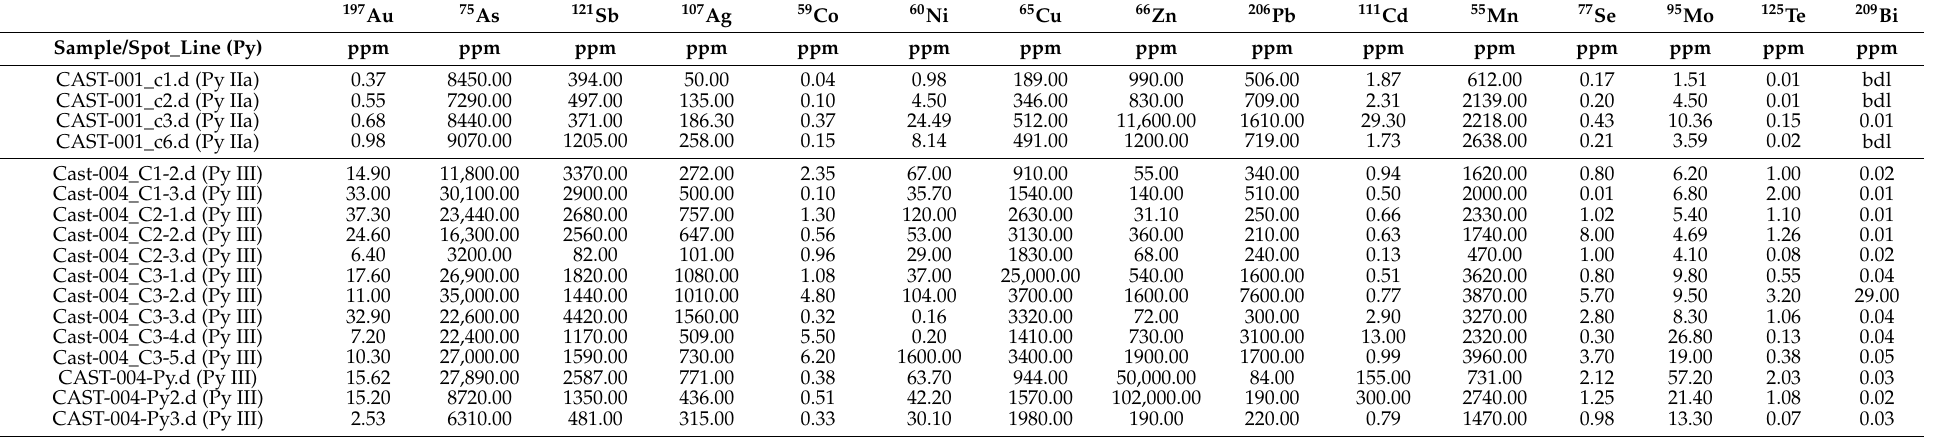
Table A2. Gold and other trace element contents in different textural types of pyrite obtained by